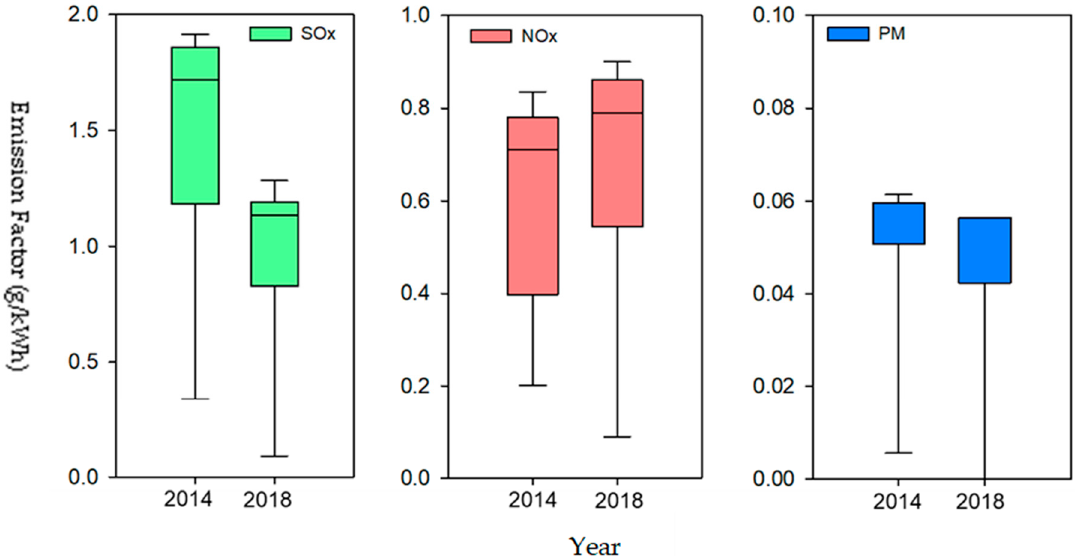
Figure 4. SOx, NOx, and PM emission factors for oil generation units in Taiwan.